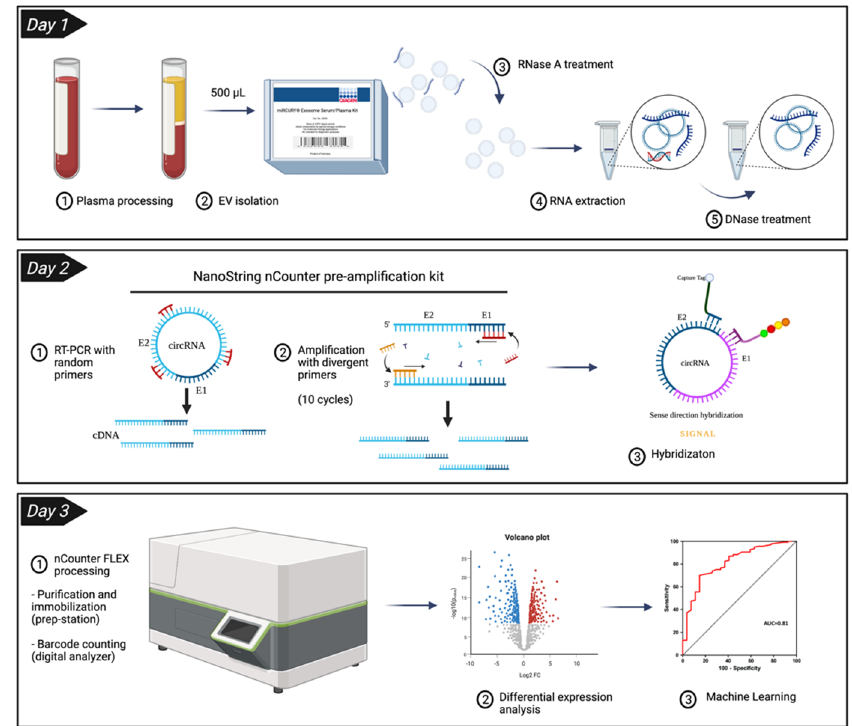
Figure 4. Final workflow established for the study of circRNAs from plasma extracellular vesicles (EVs) using the nCounter technology. A volume of 500 μ L of plasma was used in the miRCURY kit to precipitate EVs. Rnase A was used to remove any non-vesicular RNA that could be present in the sample before proceeding with manual RNA extraction with TRI reagent. RNA samples were treated with DNase to eliminate any trace of genomic DNA, followed by retro-transcription and a pre-amplification step of 10 cycles. Finally, samples were hybridized overnight before nCounter processing.